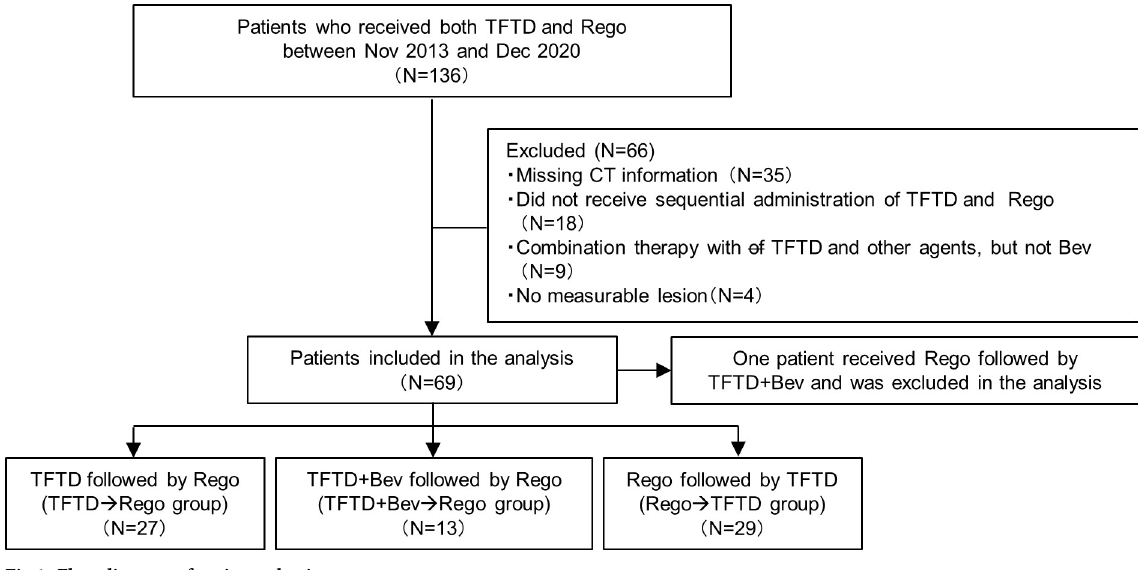
Fig 1. Flow diagram of patient